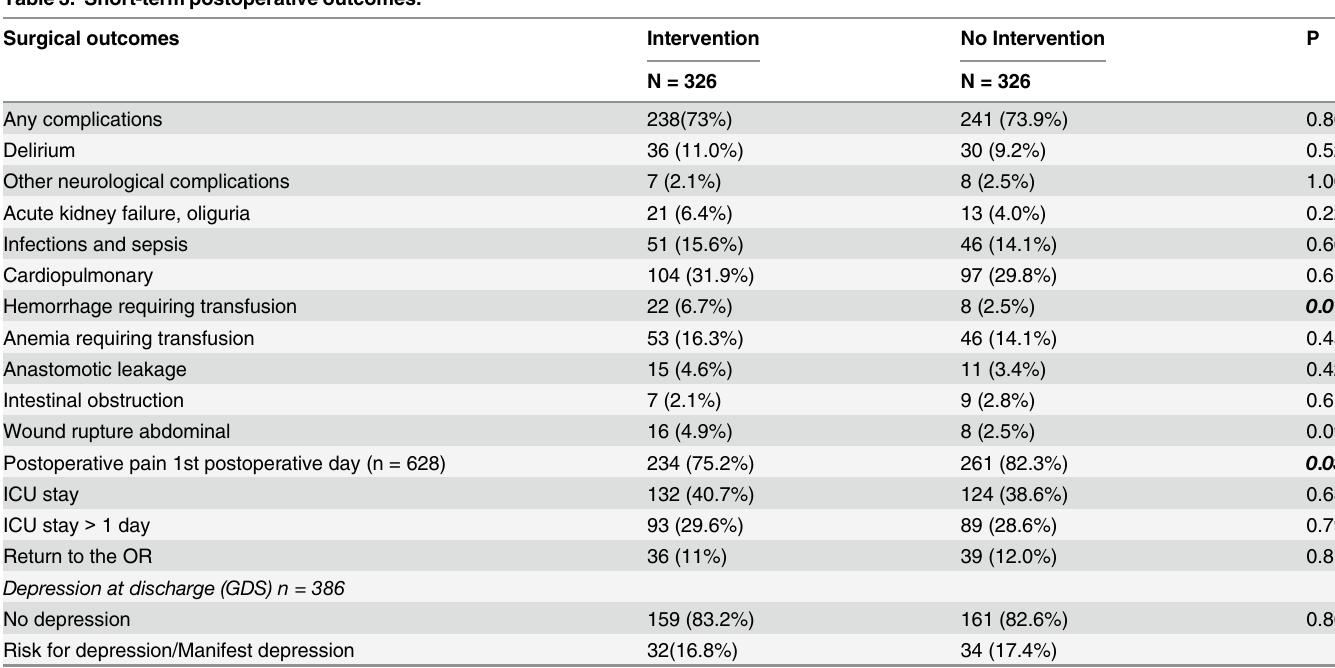
Table 3. Short-term postoperative